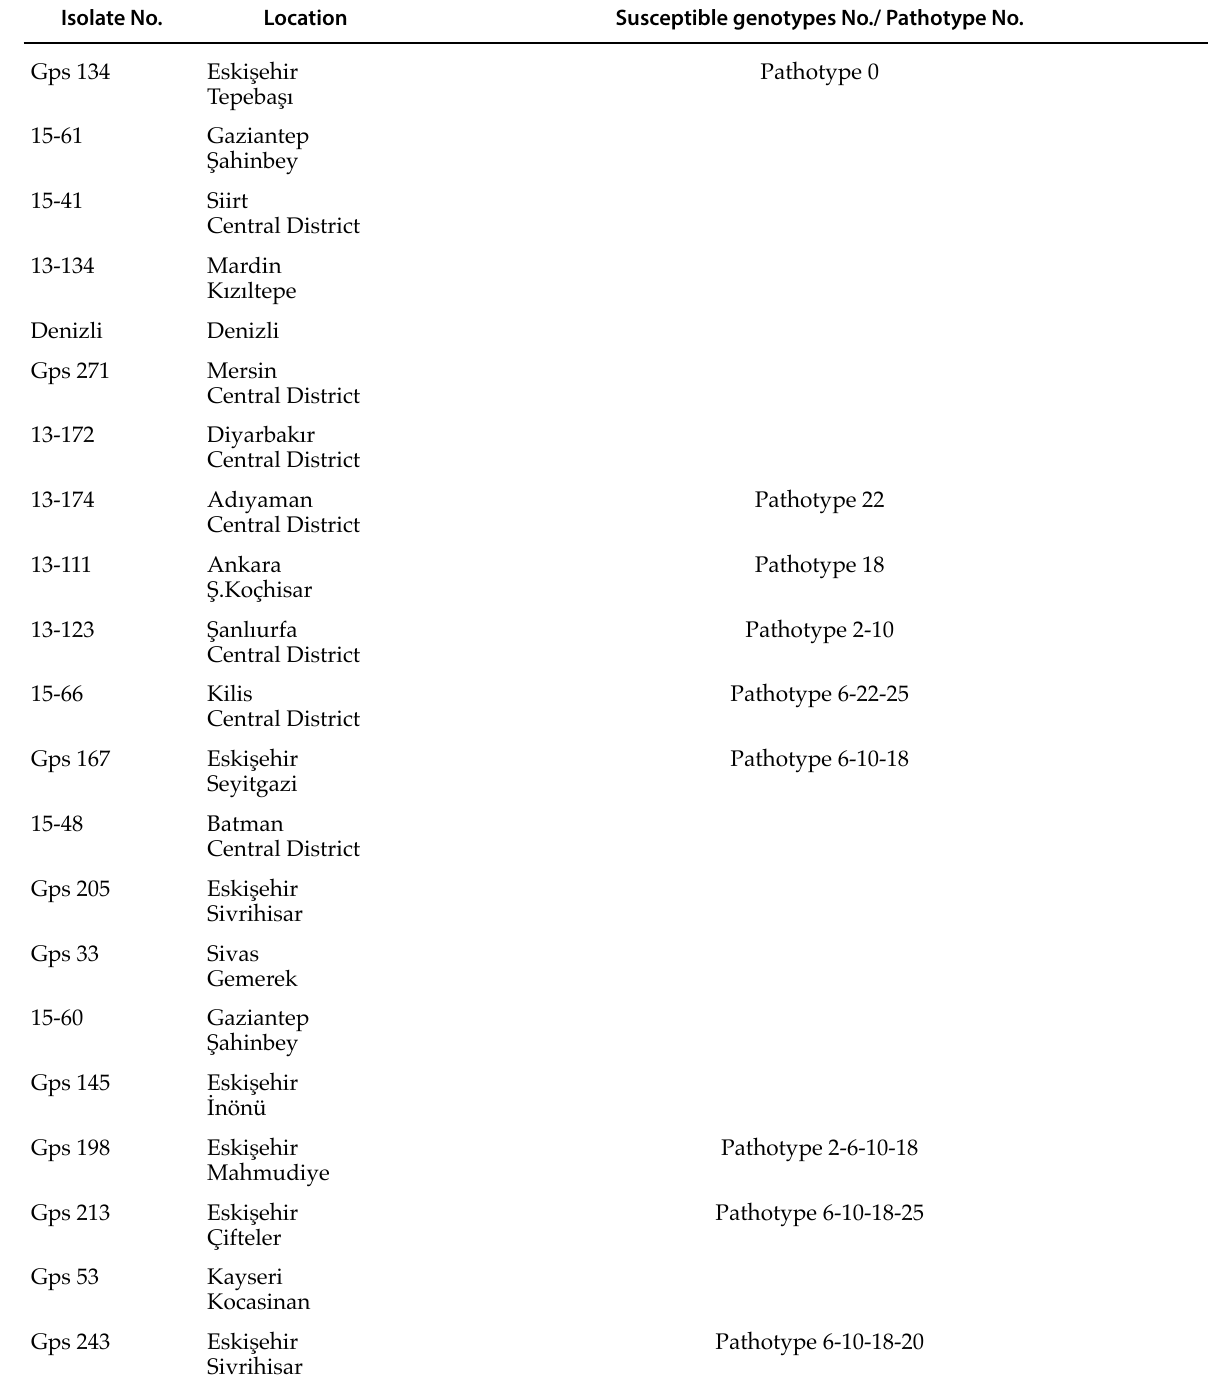
Table 2. Twenty four pathotypes of Pyrenophora teres f. teres determined in Turkey Isolate